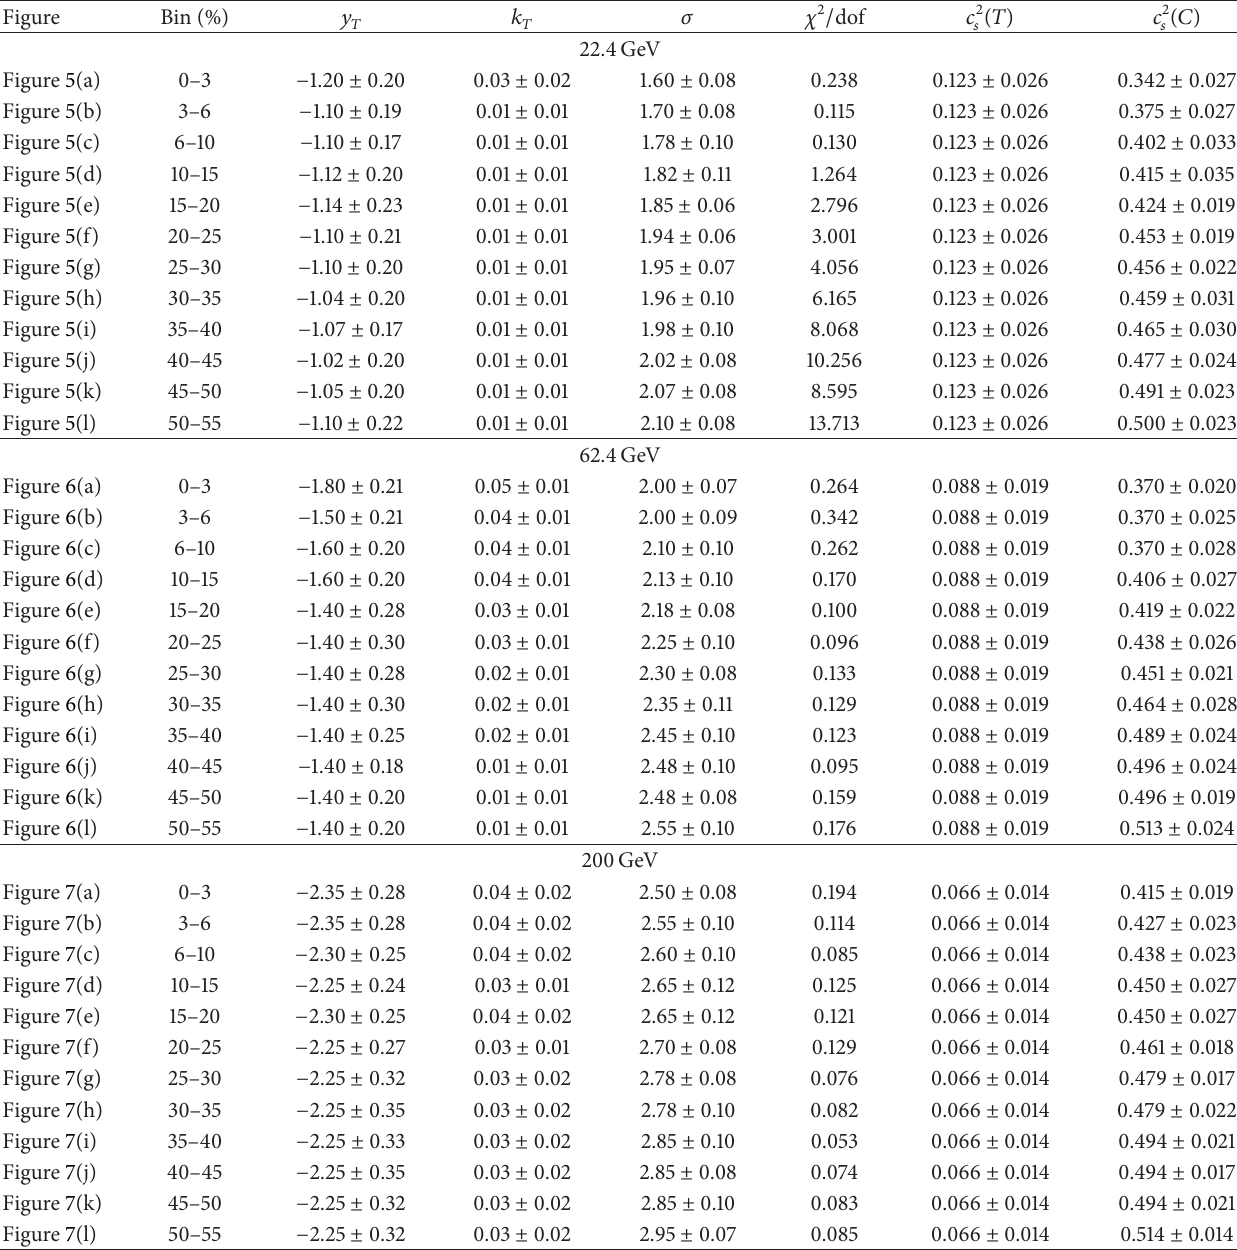
Table 2: This table is like Table 1 but is showing the results for the curves in Figures 5–7 which show Cu-Cu collisions for different energies and centralities.